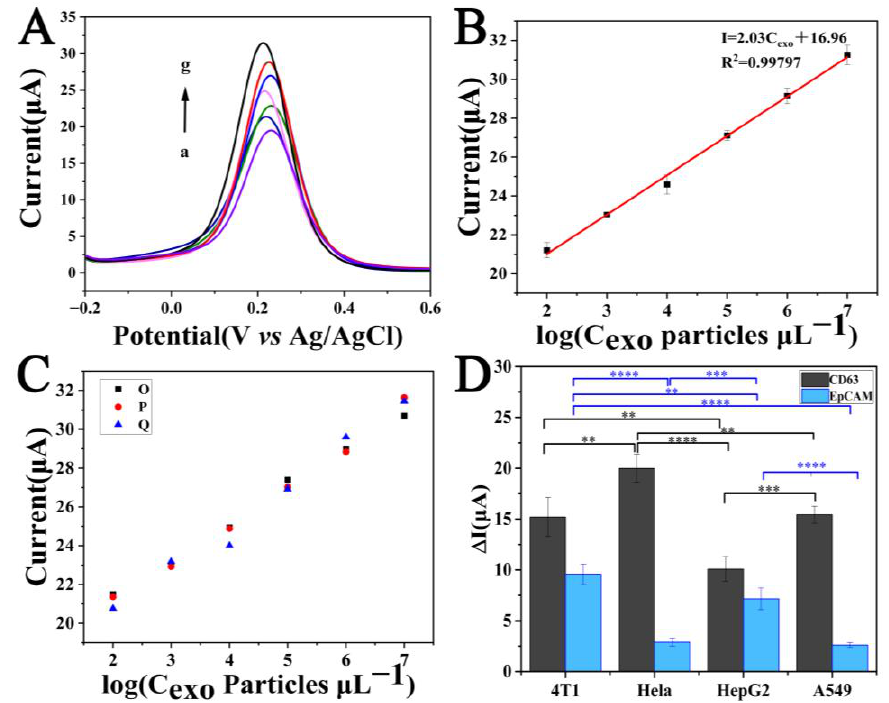
Figure 4. ( A ) DPV current of different exosome concentrations (a–g: 0, 10 2 , 10 3 , 10 4 , 10 5 , 10 6 , and 10 7 particles µ L − 1 ). ( B ) Plot of DPV intensity vs. the logarithm value of the derived exosome concentration of 4T1 cells. ( C ) DPV current of three repeated experiments at different exosome concentrations from 10 2 to 10 7 particles µ L − 1 . ( D ) DPV current of two types of cancer markers (CD63 and EpCAM) from the solution with different exosome lines (4T1, Hela, HepG2, and A549) at a concentration of 10 5 particles µ L − 1 . *: p< 0.05; **: p< 0.01; ***: p < 0.001; ****: p < 0.0001. Black symbol “*” represents CD63 and blue symbol “*” represents EpCAM.